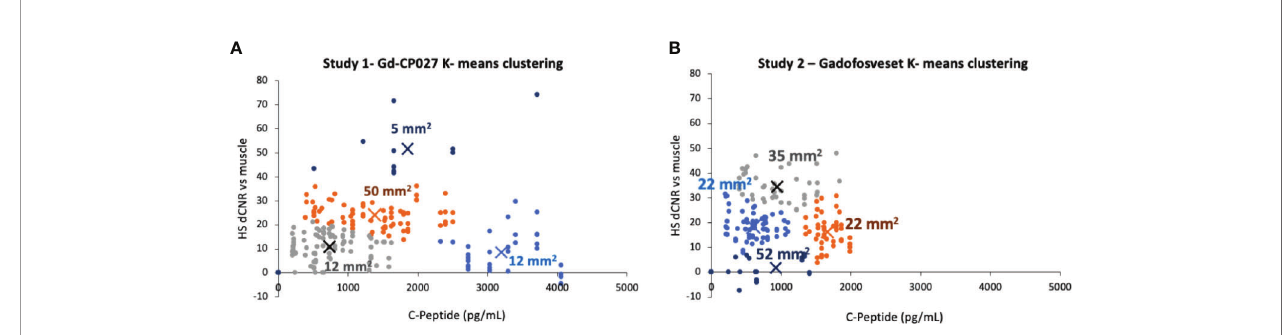
FIGURE 5 | K-means clustering (k = 4 for both studies) showing the change in contrast-to-noise ratio versus the corresponding blood C-peptide measurement for all animals and all hotspots, where “ X ” represents the centroid of each cluster labeled with its respective average hotspot area for animals receiving (A) Gd-CP027, or (B)